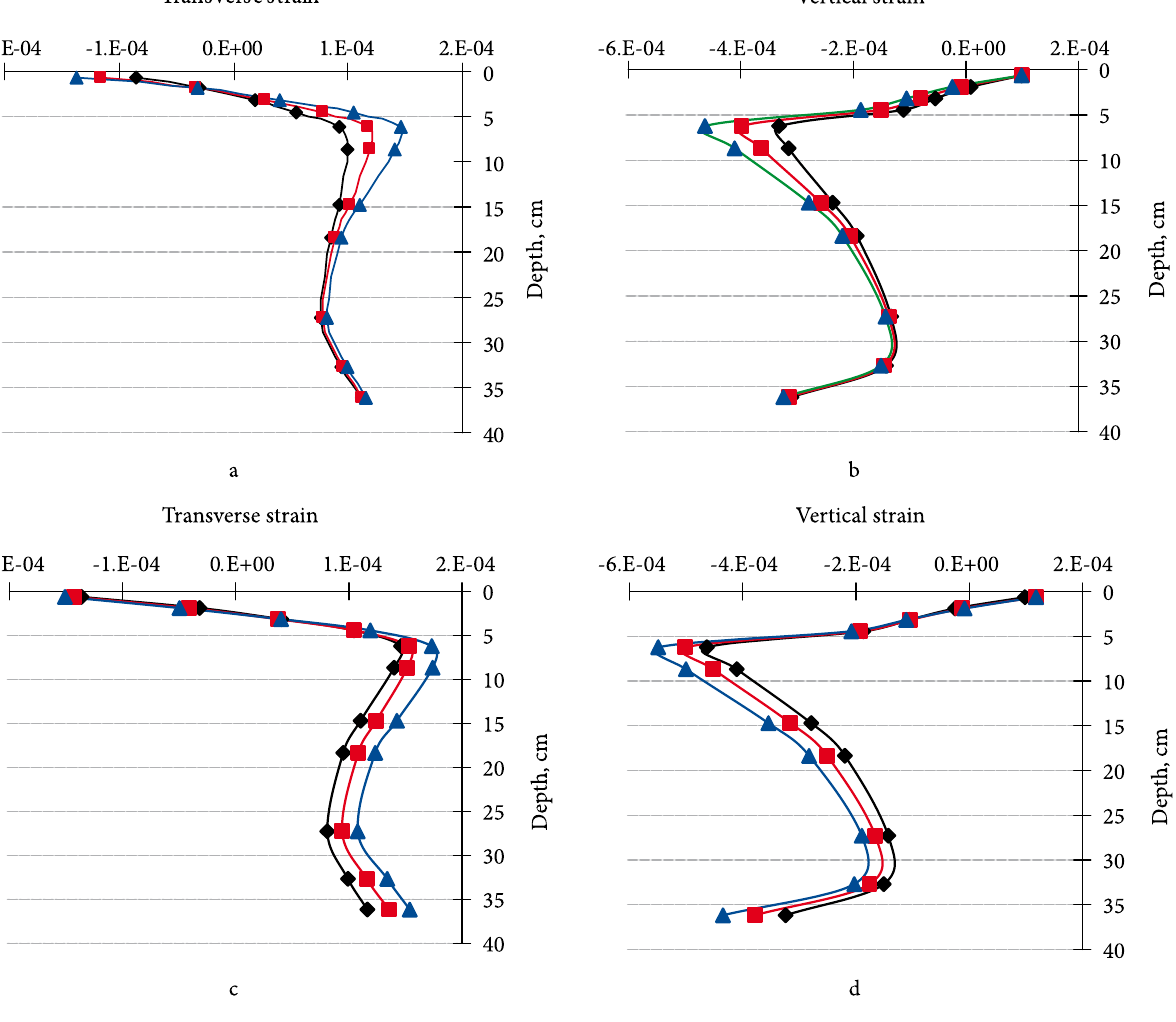
fig. 5. Predicted transverse and vertical strains for the case 1 of Table 2 by 11 R 24.5 radial tire: a, b – increased tire inflation pressure; c, d – increased tire load